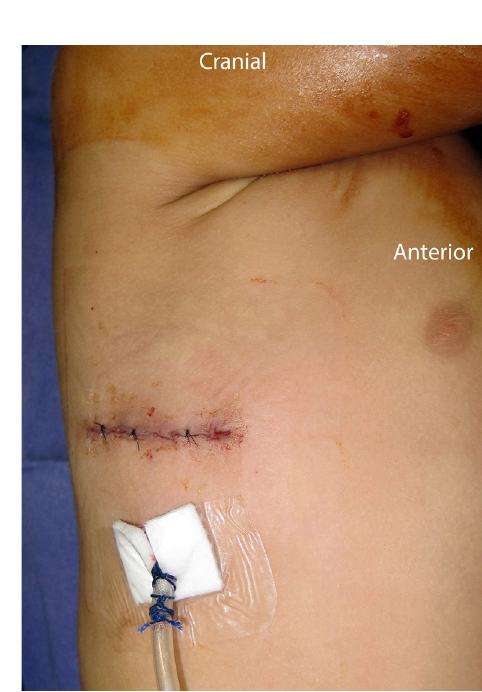
Fig. 2 - Incision aspect at the end of operation Fig. 3 - Aesthetic aspect of the thorax with hidden incision under the